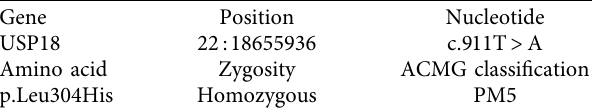
Table 1: Result of single exome sequencing analysis.